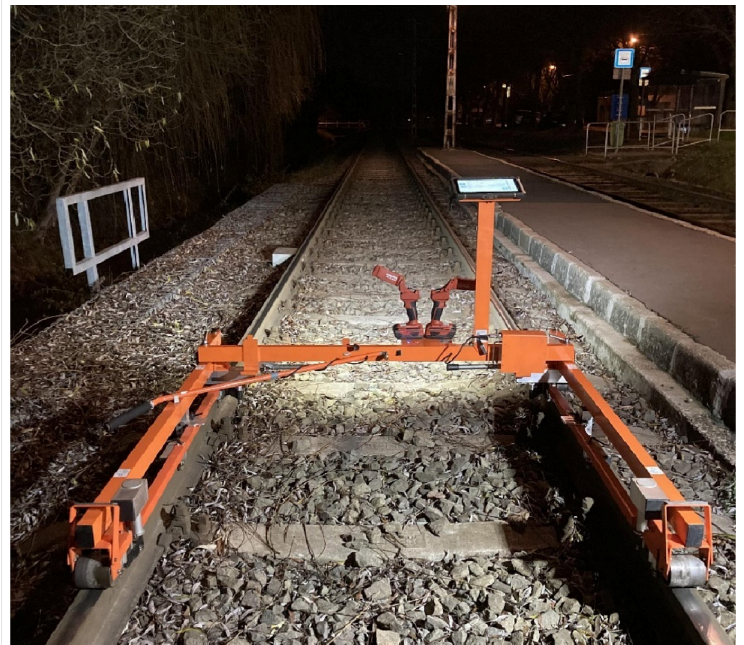
Figure 9. TrackScan 4.01 instrument (own